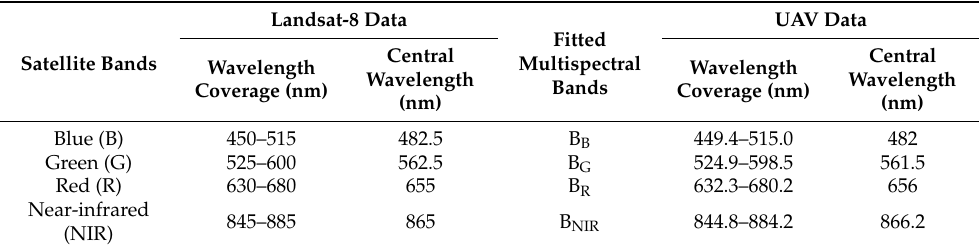
Table 2. Band information for Landsat-8 satellite multispectral data and fitted unmanned aerial vehicle (UAV) multispectral data.